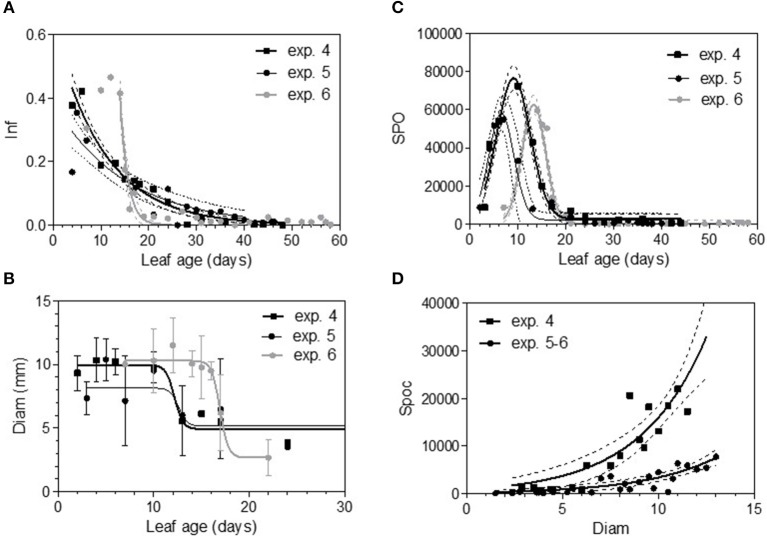
Infection efficiency rate (Inf) (A), colony diameter (Diam) (B), and sporulation (number of spores produced per cm2 of infected leaf disc) (Spo) (C) as a function of leaf age and sporulation per colony (Spoc) as function of colony diameter (D) for Merlot experiments. Plain lines correspond to the fitted models M1 (A), M2 (B), M3 (C), and M4 (D) in Table 5. Dashed lines correspond to the 95% confidence bands on the models, and bars correspond to the standard deviation.